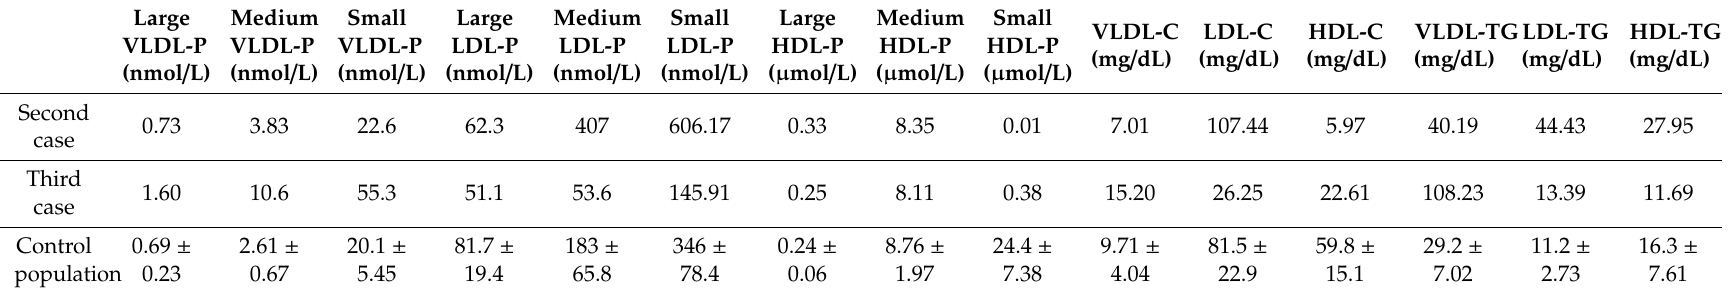
Table 2. Results of Liposcale